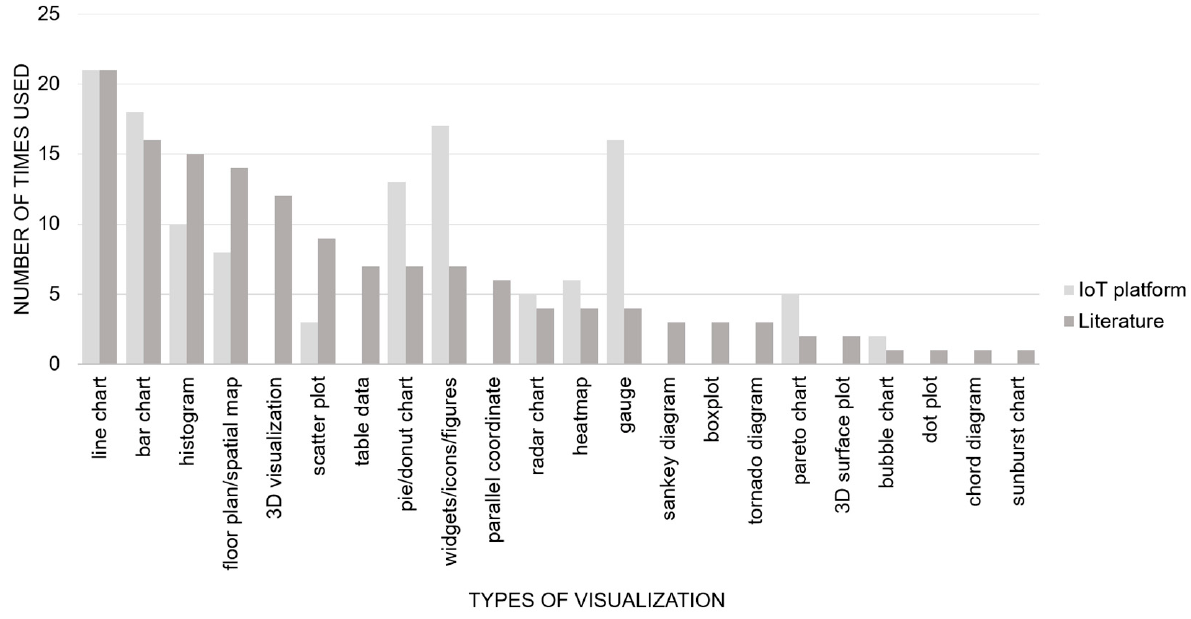
Figure 1. Visualization types found in scientific literature and IoT platform review. There is a propensity to use graphs that allow data to be grouped while maintaining accurate values. These visualizations tend to be clear, simple, and functional, rather than aesthetic. This result is presumed to be because 90% of these graphs are primarily intended for an expert